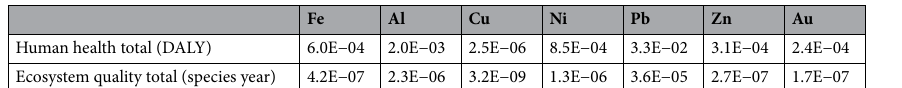
2 . This is specifically the case for lead and aluminium production. The environmental performance of